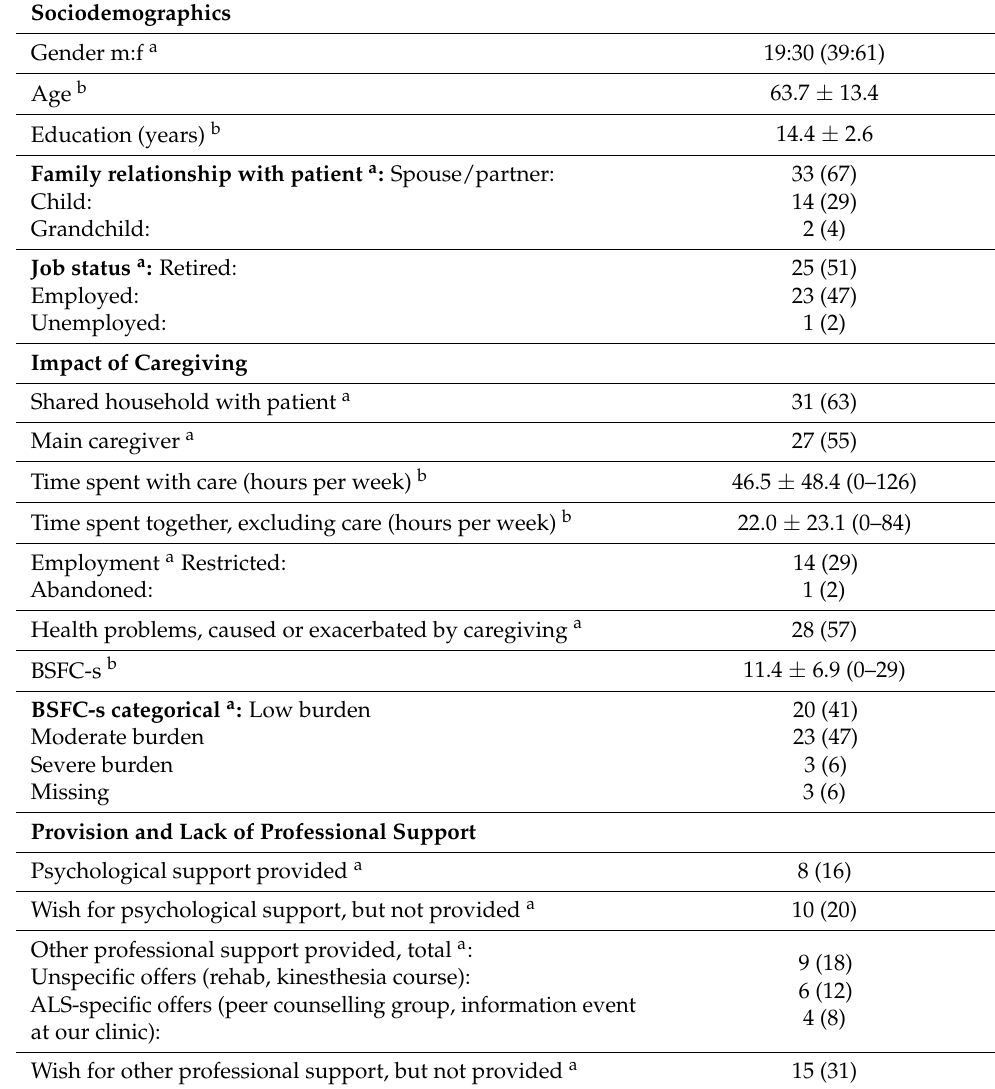
Table 1. Characteristics of the n = 49 interviewed